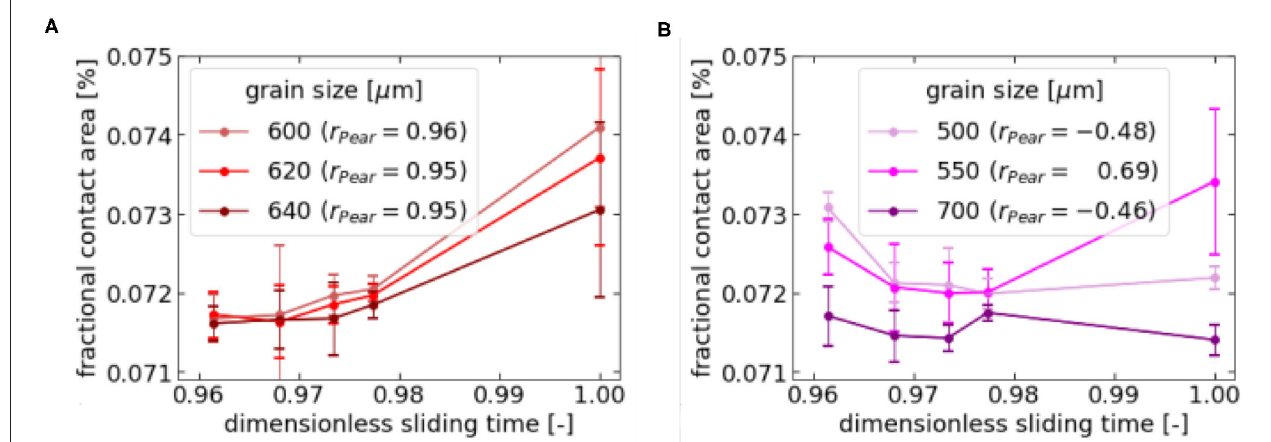
FIGURE 6 | Fractional contact area as a function of the dimensionless sliding time of skis with grinding structure S1–S5. Grain sizes representing the grain size distribution of the experimental snow exhibit monotone relations between A fr and dimensionless sliding time (A) , while for grain sizes outside the range of the grain size distribution no significant correlations can be detected (B) . The dimensionless sliding time is defined by the sliding time of each ski divided by the sliding time of the slowest ski. The strength of the correlations in (A,B) is measured by the Pearson correlation coefficient r Pear ; see Equation (10). Note, that for a significance of α = 0.05 an | r Pear | ≥ 0.88 is required.